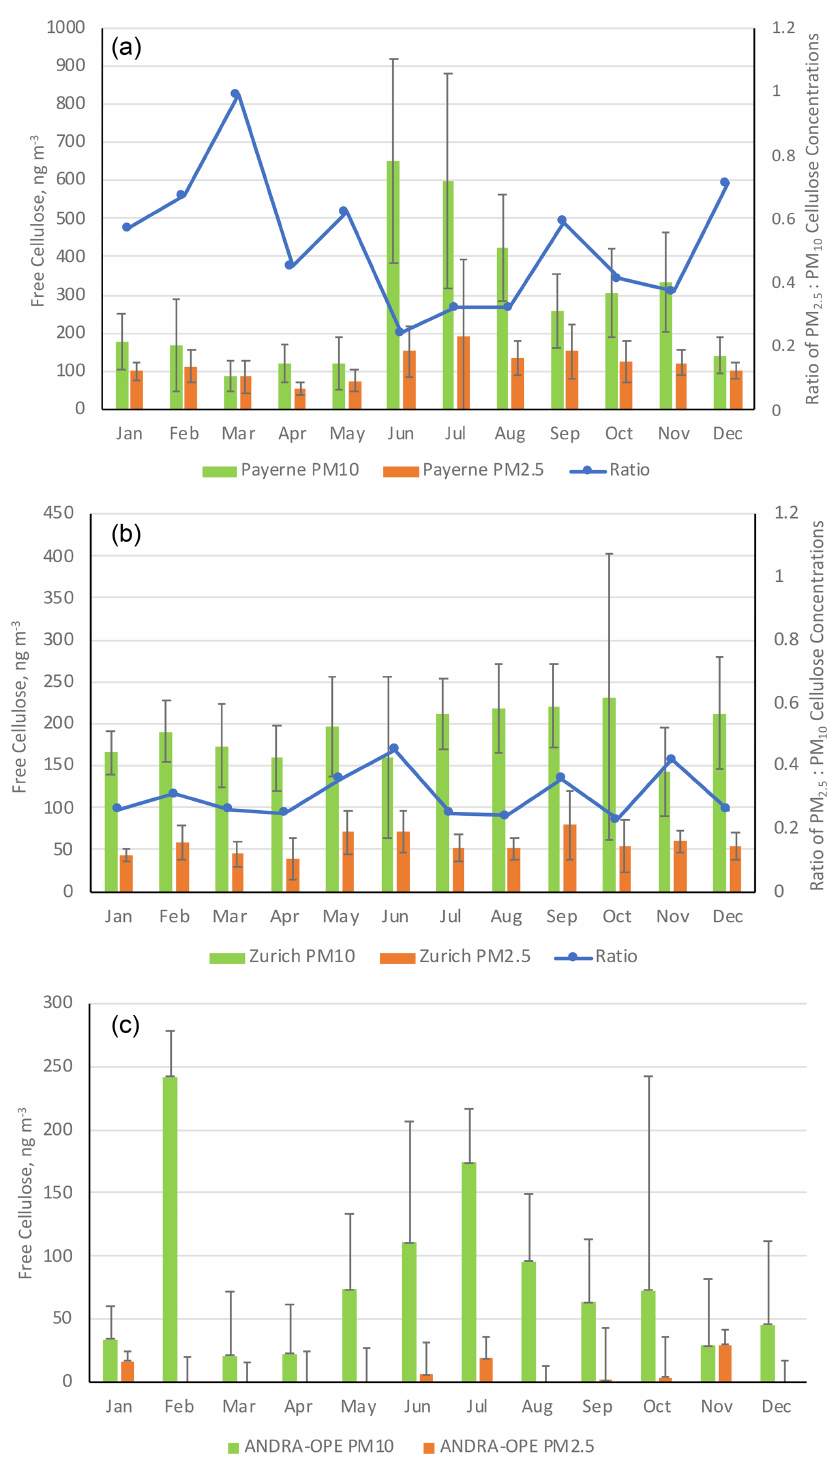
Figure 3. Monthly averages of cellulose concentrations within PM 10 (green bars) and PM 2 . 5 (orange bars) at the three sampling sites of Payerne (rural, a ), Zurich (urban, b ), and ANDRA-OPE (rural, c ). Black error bars represent 1 standard deviation of the results. The corresponding blue lines represent the ratio of the monthly mean cellulose concentrations in PM 2 . 5 :PM 10 . Note that ANDRA-OPE data are only for the year of 2020, and only positive error bars are used for clarity (SD larger than